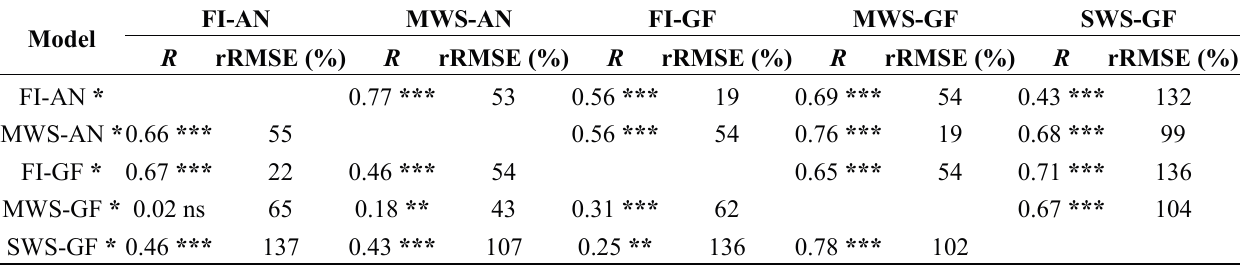
Table 3. Coefficients of correlation of individual models applied to different environments. Coefficients of regression generated by each water regime (SWS, MWS and FI) and phenological stage (AN and GF) were used for yield predictions in the different conditions. Model